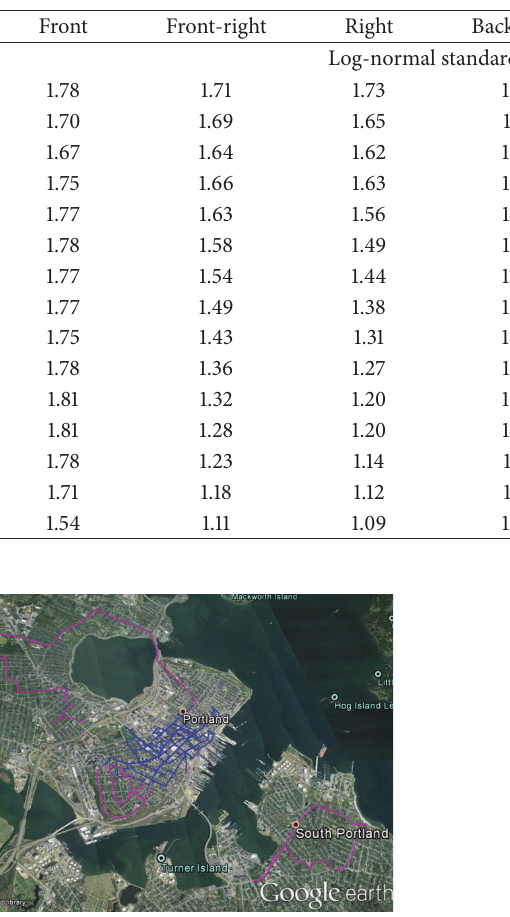
Figure 4: Measurement route in Portland (Maine) across urban (blue) and suburban (magenta)